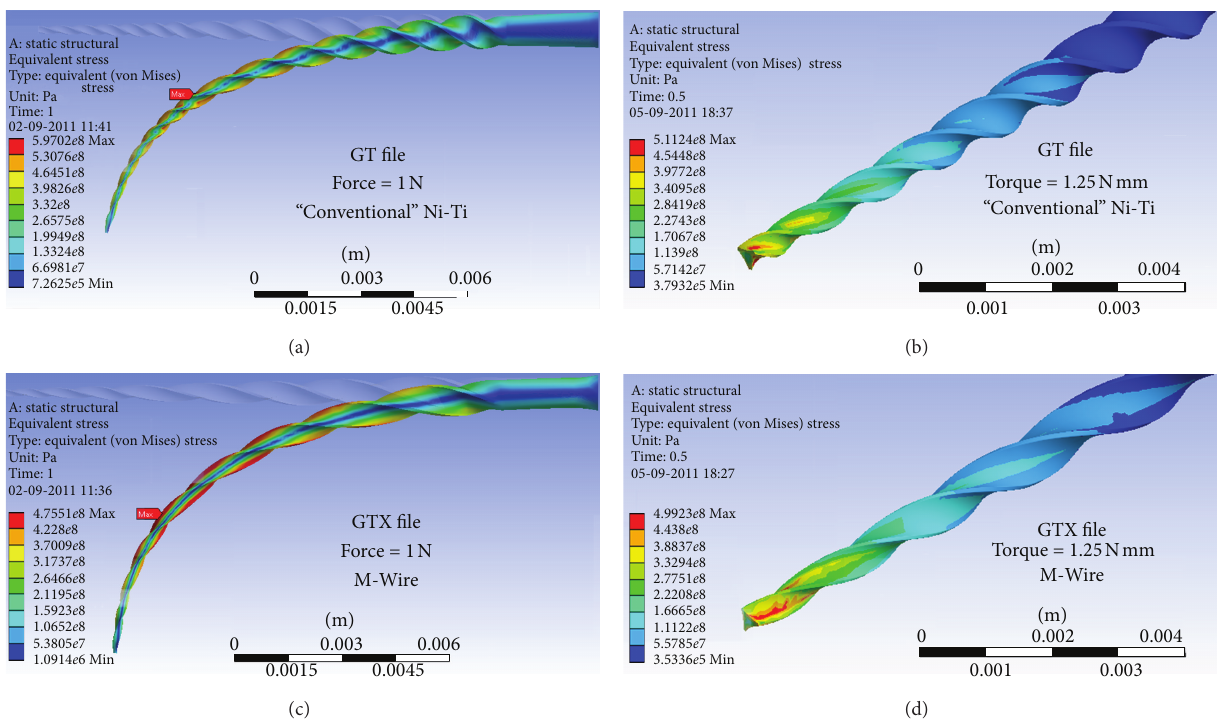
Figure 5: ((a), (c)) Flexural von Mises stress distribution for a 1N load at the tip. ((b), (d)) Torsional von Mises stress distribution for a 1.25 Nmm torque with the file clamped 4 mm away from its tip.